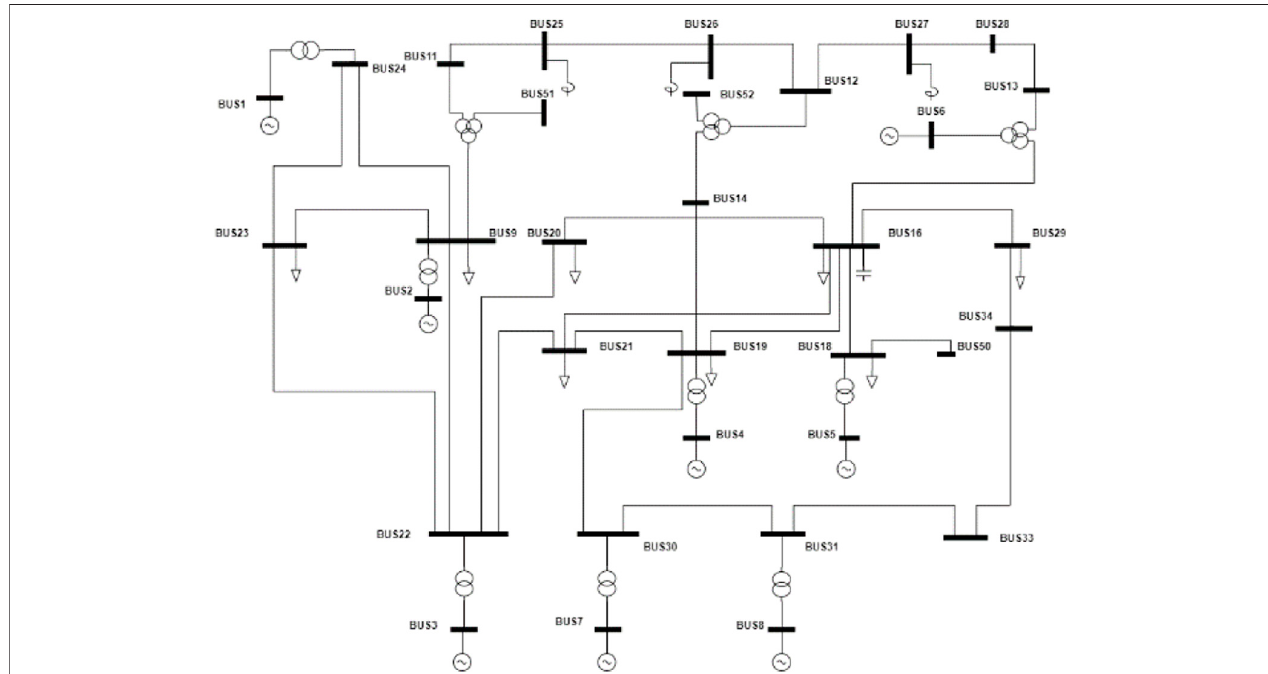
FIGURE 7 | CEPRI36 grid model topology connection